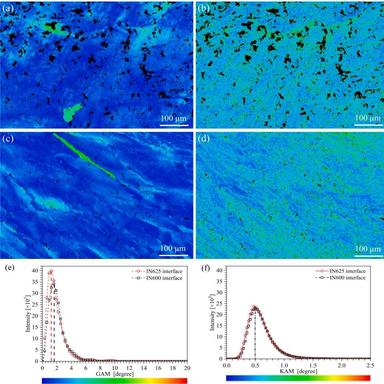
Weld metal EBSD misorientation maps (a and b) GAM, (b and d) KAM, and (e and f) their corresponding histograms.